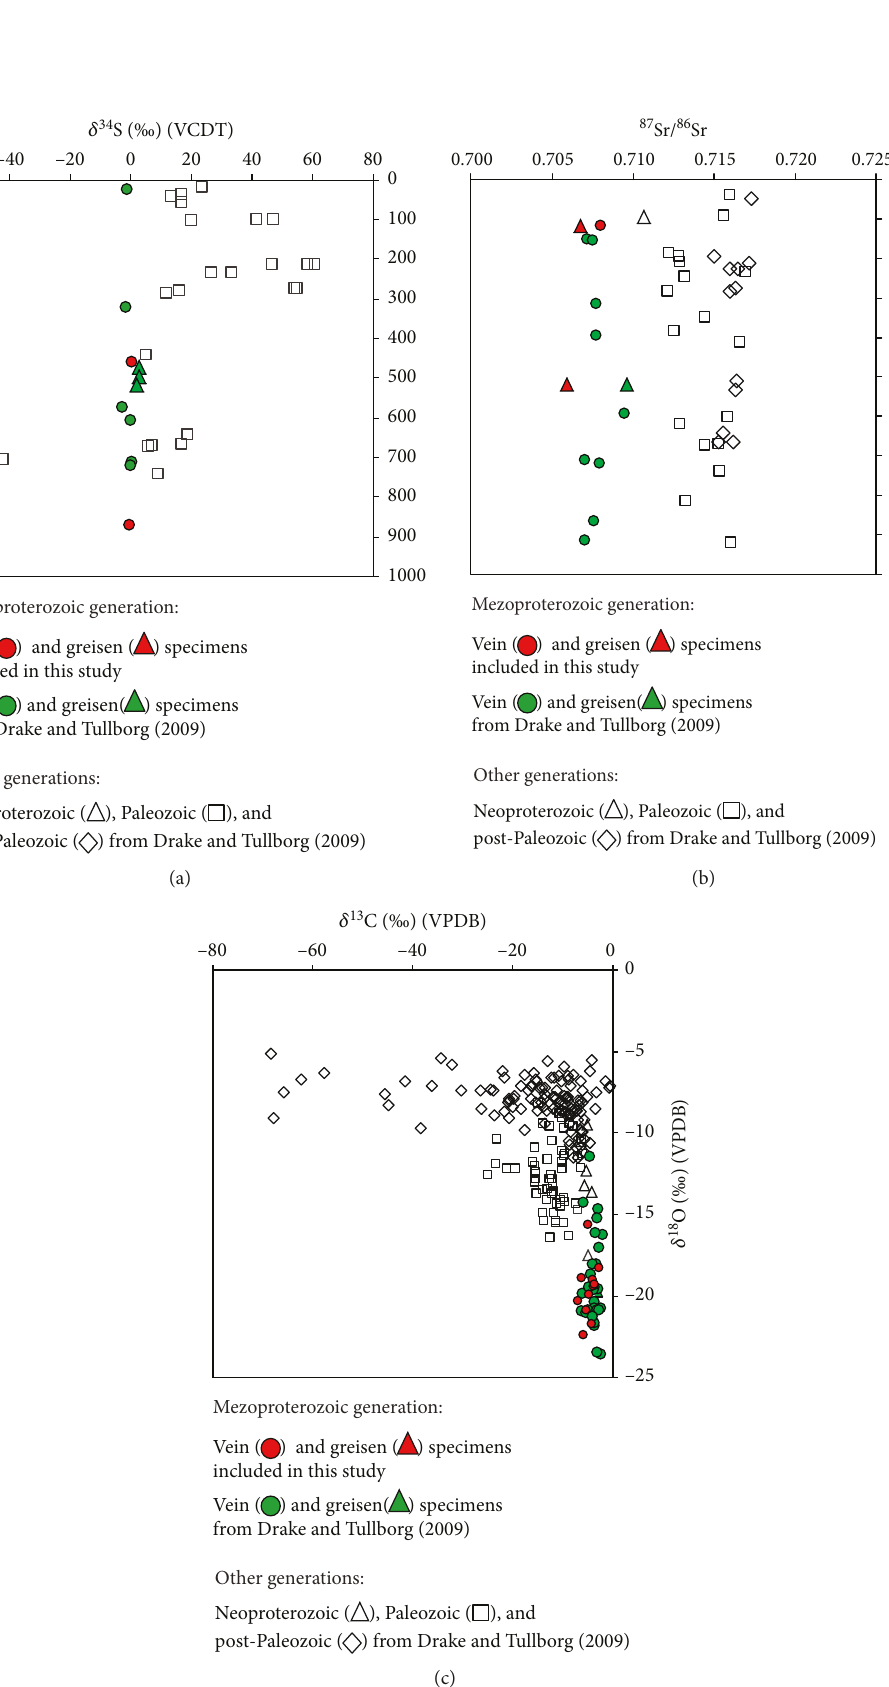
Figure 7: Isotopic composition of Mezoproterozoic minerals compared with isotopic composition of minerals of Neoproterozoic, Paleozoic, and post-Paleozoic minerals occurring at the site, collected in this study, and collected previously in Drake and Tullborg